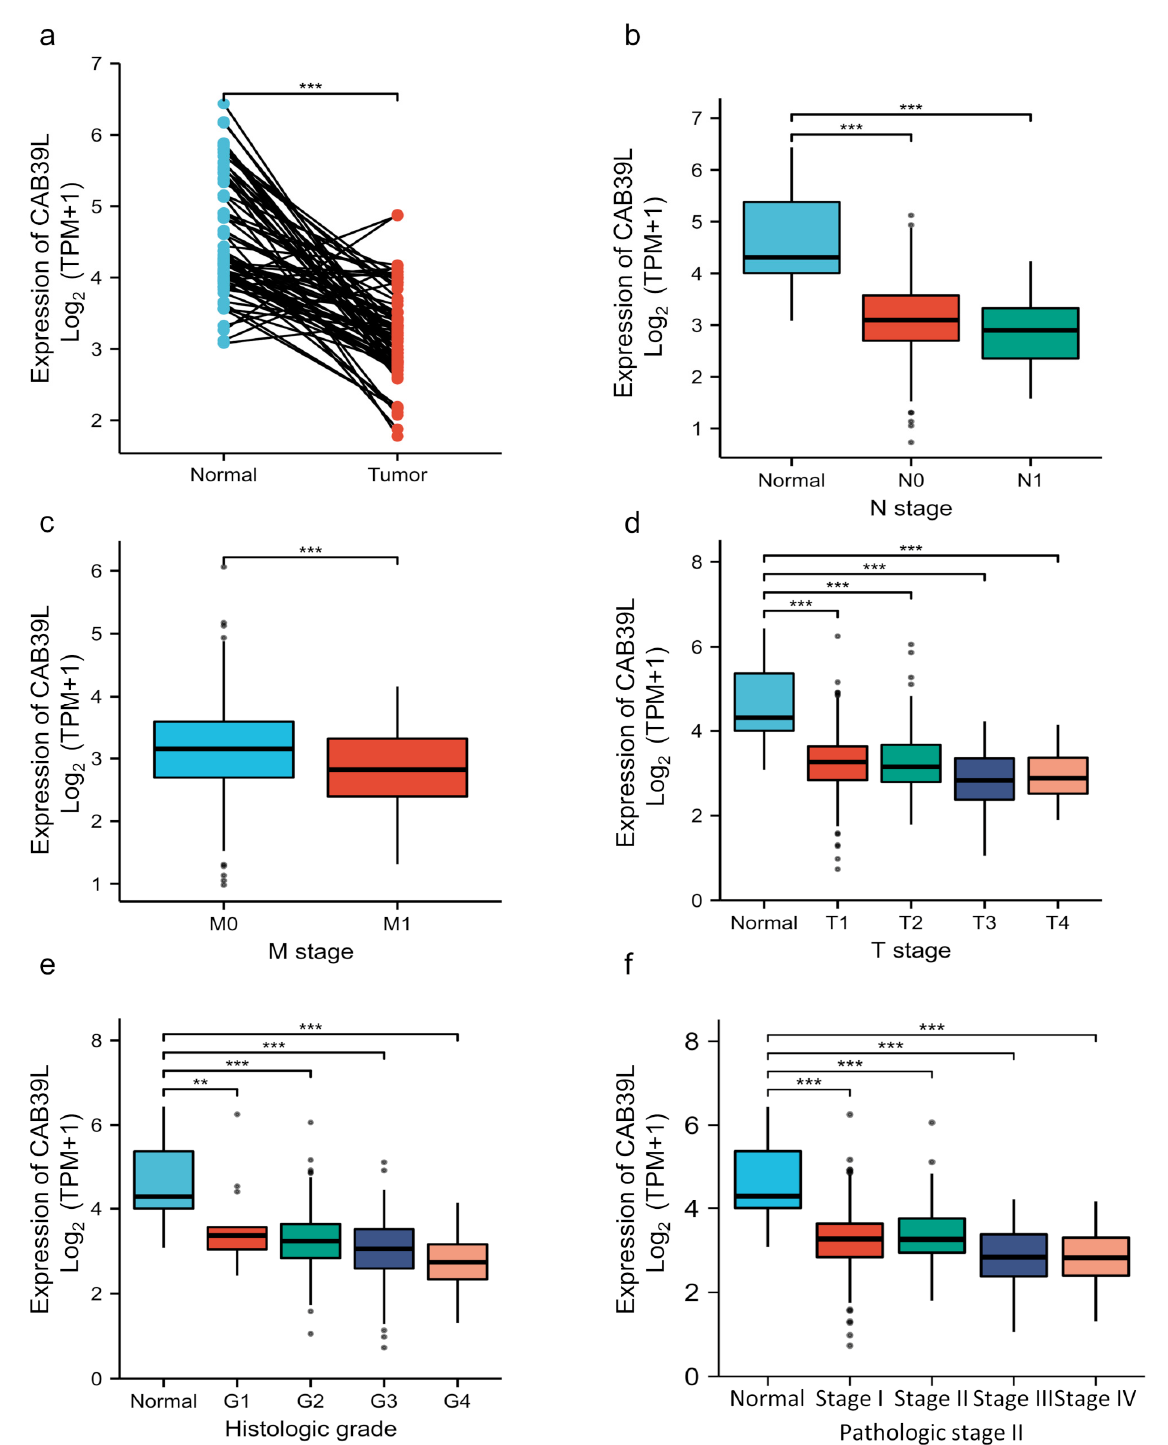
Figure 2. Analysis of the transcriptional level of CAB39L and its association with clinical parameters of KIRC patients (TCGA). ( a ) mRNA expression of CAB39L in 72 KIRC samples and adjacent non-tumor samples. ( b ) Relationship between the mRNA expression of CAB39L and N stage. ( c ) Relationship between the mRNA expression of CAB39L and M stage. ( d ) Relationship between the mRNA expression of CAB39L and T stage. ( e ) Relationship between the mRNA expression of CAB39L and histologic grade. ( f ) Relationship between the mRNA expression of CAB39L and pathologic stage. T: tumor size; M: distant metastasis; N: lymphatic metastasis; ** p < 0.01, *** p < 0.001.